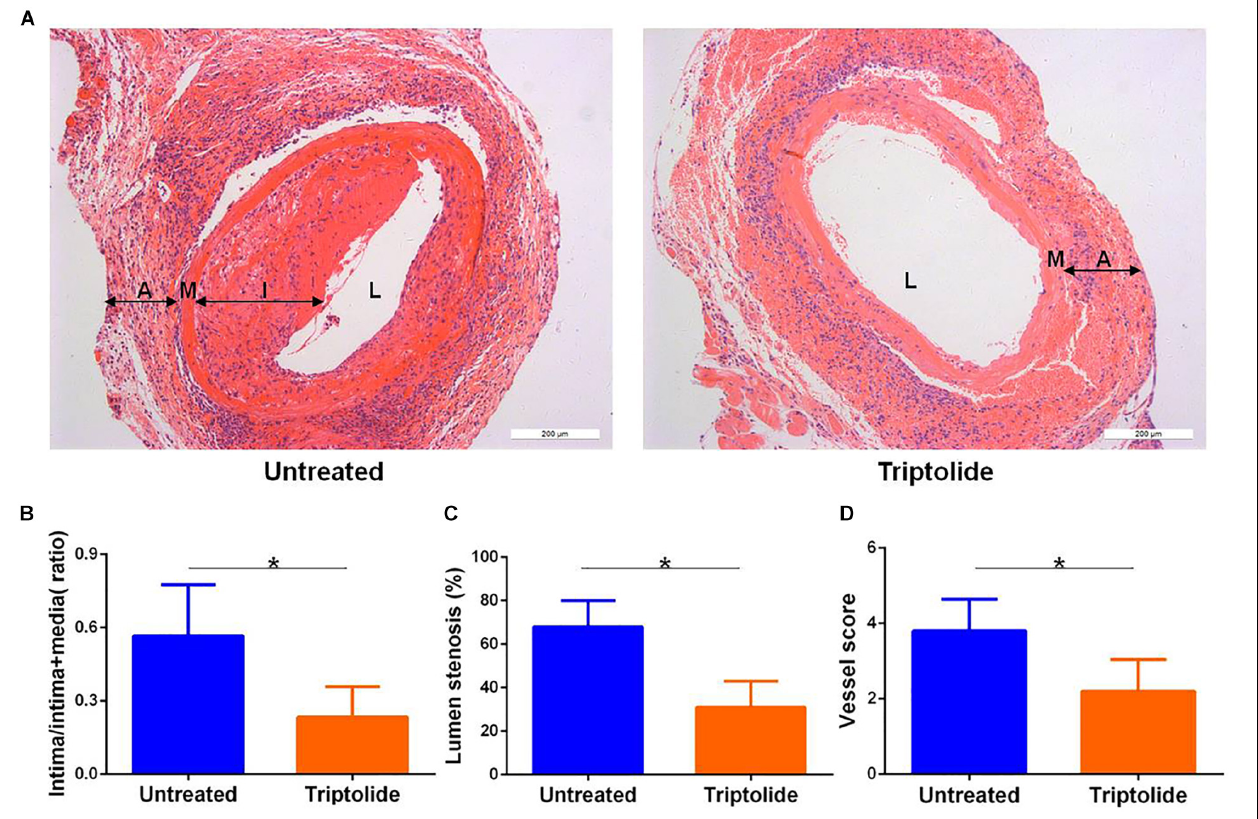
FIGURE 1 | Triptolide inhibits intimal hyperplasia in murine aortic allografts. (A) Representative photomicrographs of hematoxylin and eosin stained whole (100 × ) vascular allografts 4 weeks after transplantation showing TV lesions. (B) Intima/intima + media ratio (C) lumen stenosis, and (D) vessel score. Data were represented as mean ± SD ( n = 5). * p < 0.05 vs. untreated Student’s t -test. A indicates adventitia; M, media; I, intima; and L,